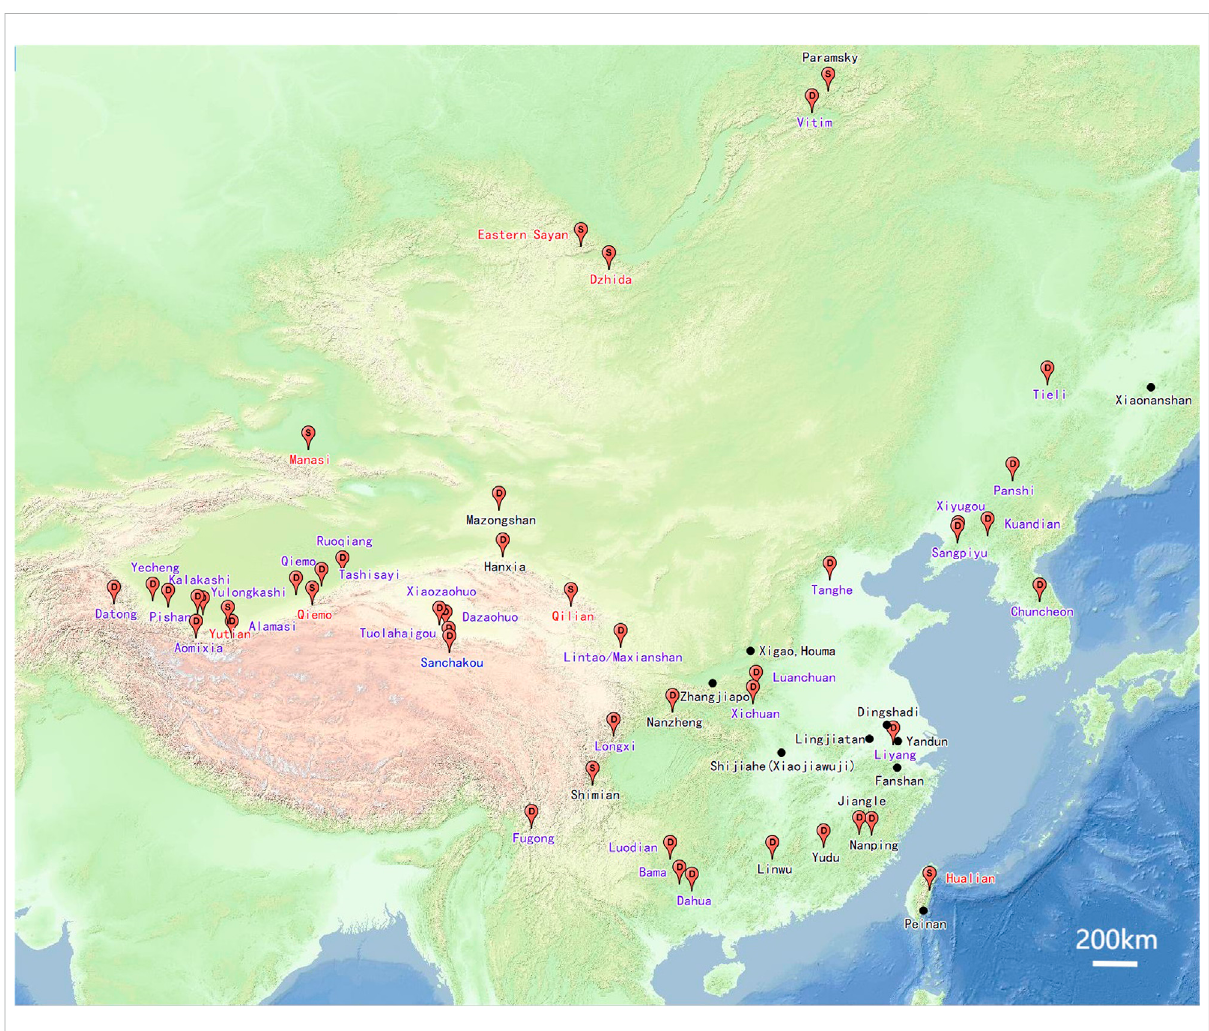
FIGURE 1 Distribution of reported nephrite deposits and the sites where jadewares were excavated in Northeast Asia (D mark with blue word represents D-typenephrite,Smark withredwordrepresentsS-typenephrite,DmarkorS markwithblack wordrepresents thenephritedeposithas noisotopic studies and black dot with black word represents archaeological site mentioned in this article. Ancient jades from Qijia Culture (2300 – 1500BC) and Anhui Province are not marked because of the unknown